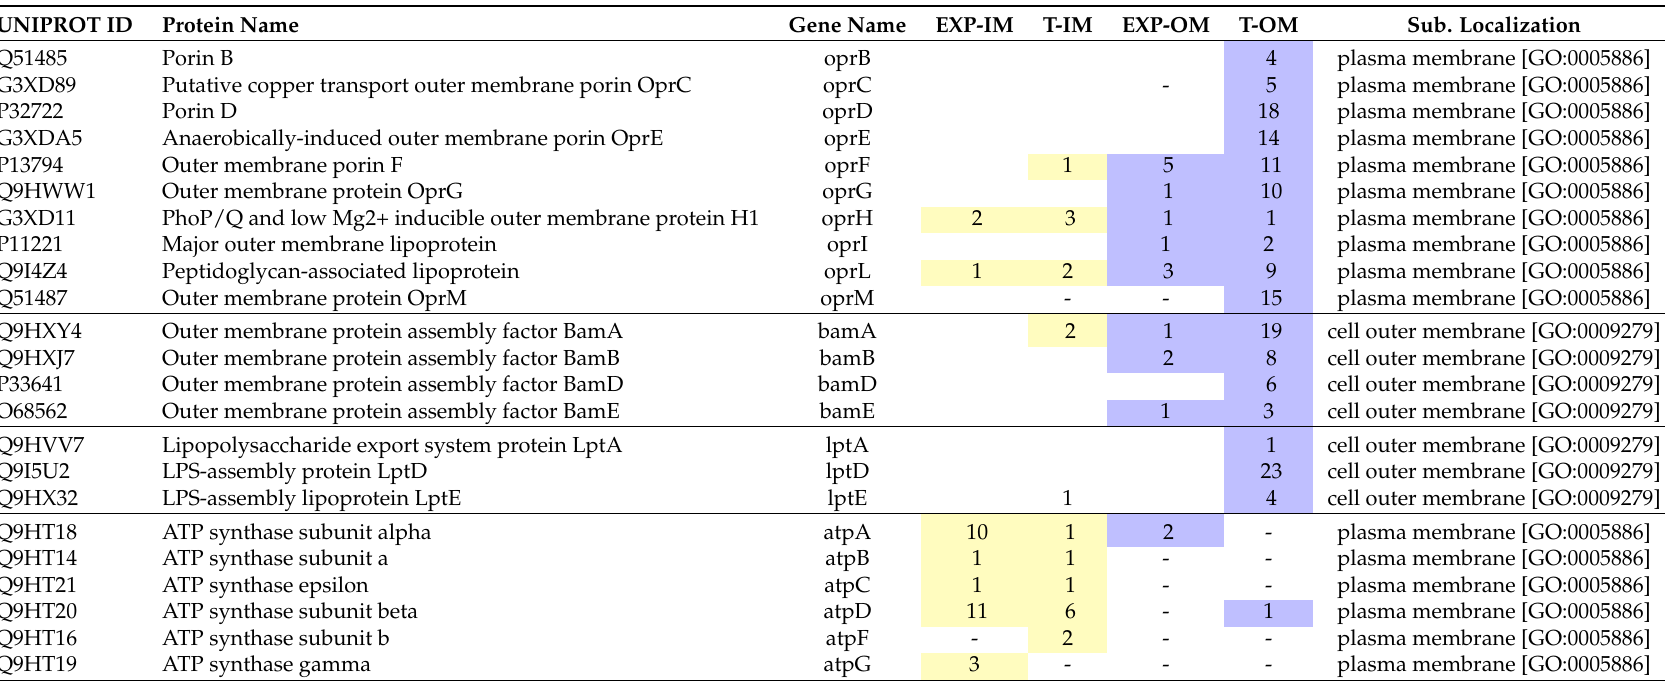
Table 1. Classification of peptides from P. aeruginosa proteins localized in membranes. The number of inner- and outer-membrane classified peptides per protein is highlighted in yellow and blue, respectively. T-IM: Trans-Inner Membrane, T-OM: Trans-Outer Membrane, EXP-IM: Inner-Membrane Exposed, EXP-OM: Outer-Membrane Exposed; full data reported in Table